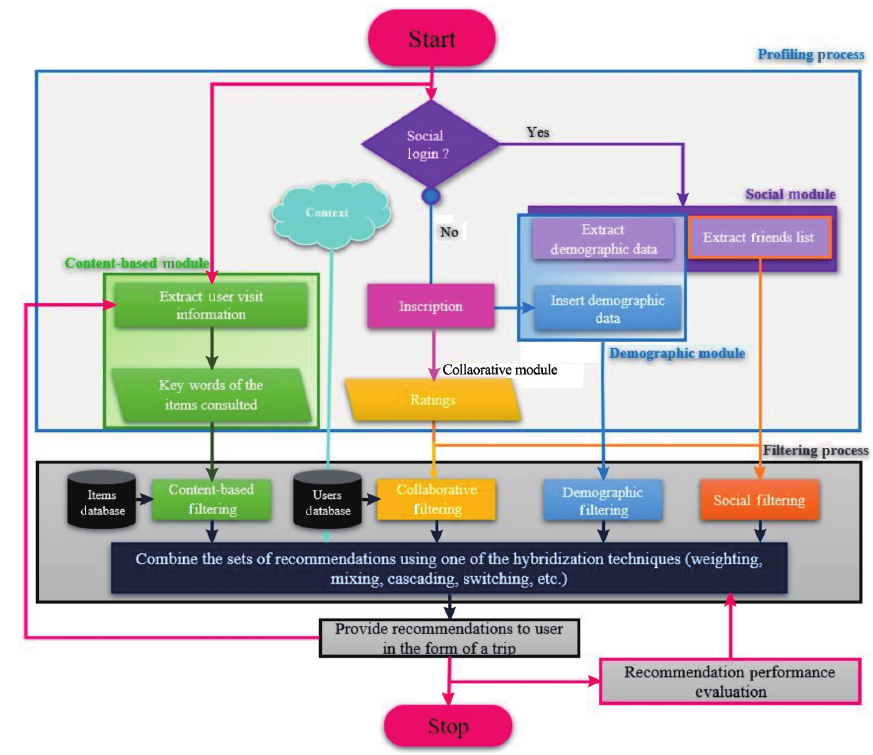
Fig. 2 Flowchart of the conceptual